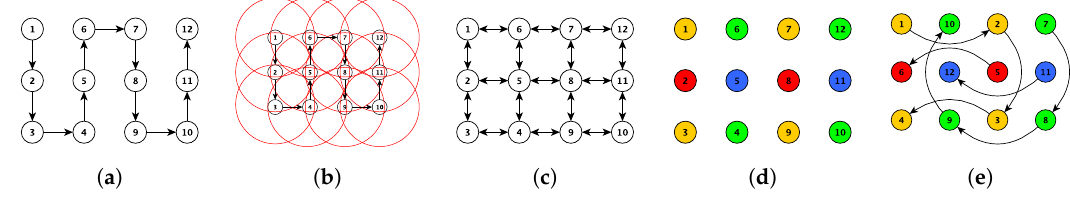
Figure 6. Spaced visiting sequence; ( a ) Normal survey path R ; ( b ) A new graph is created, the red circles are the distance threshold to connect to neighbors; ( c ) Neighbors connected G ; ( d ) Edges labeled by color; ( e ) Final